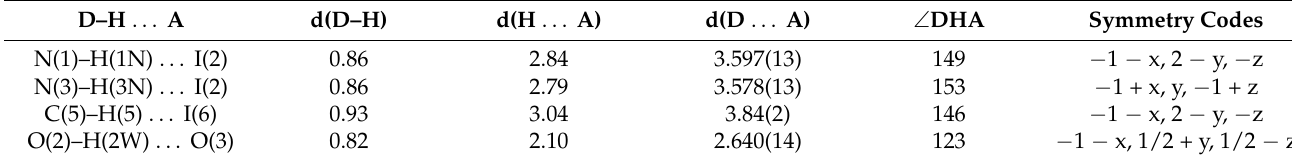
Table 2. Hydrogen Bond Lengths (Å ) and Bond Angles (°).